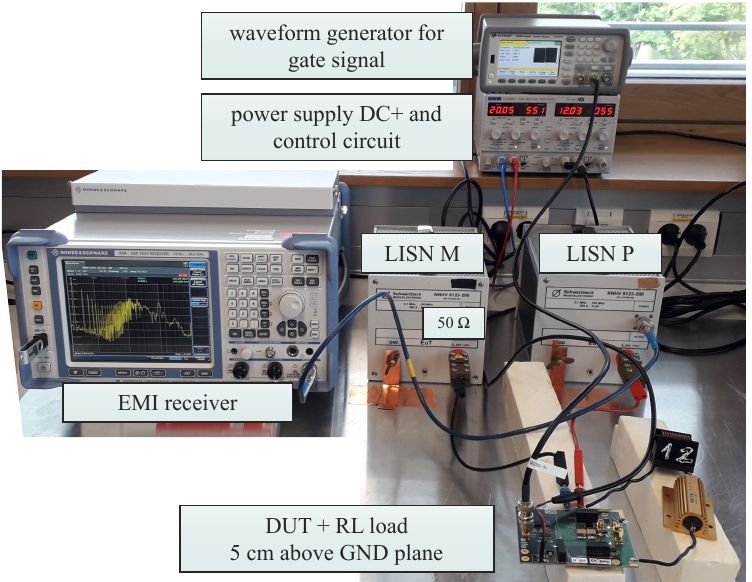
Figure 5. Photo of the conducted emission measurement setup. The EMI receiver was connected to the output of the positive supply LISN P. Common GND is the metallic plane. The unused output of LISN M was terminated by 50 Ω . Wires between DUT PCB and LISNs were 30 cm